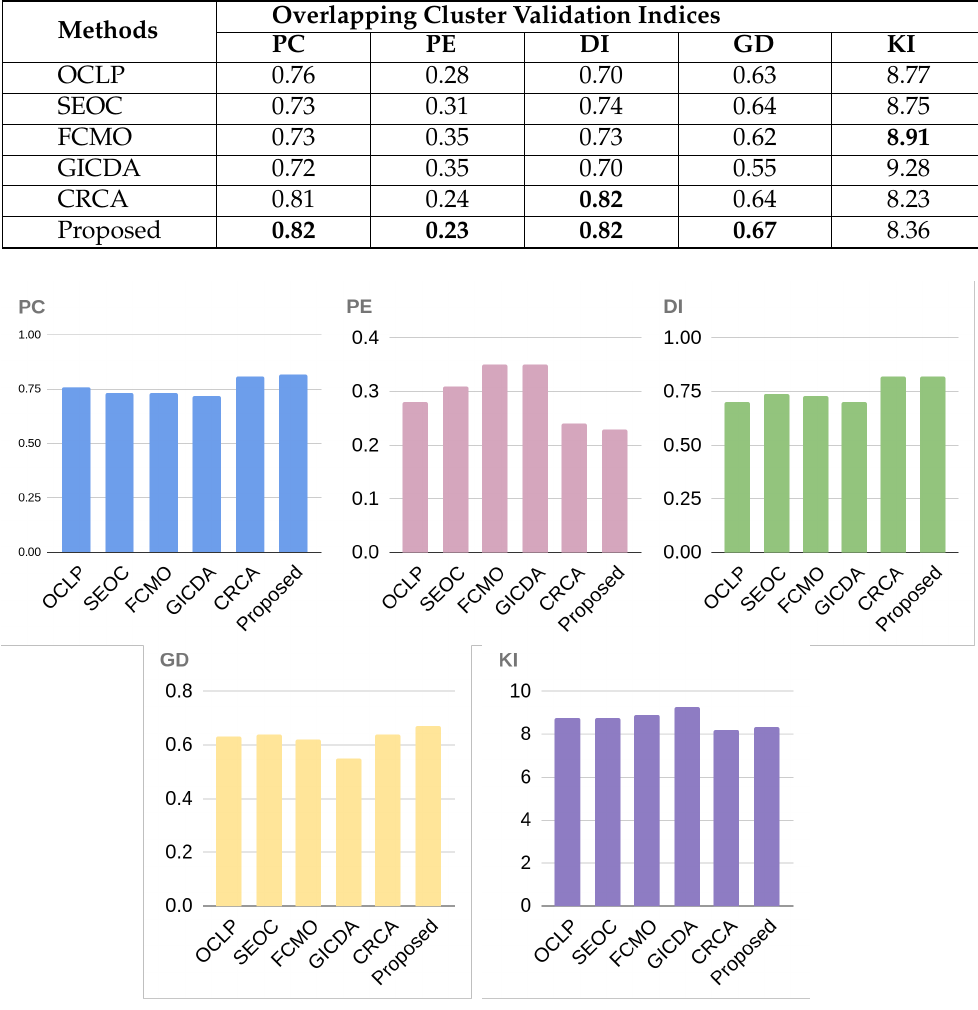
Figure 6. Average Comparison of overlapping